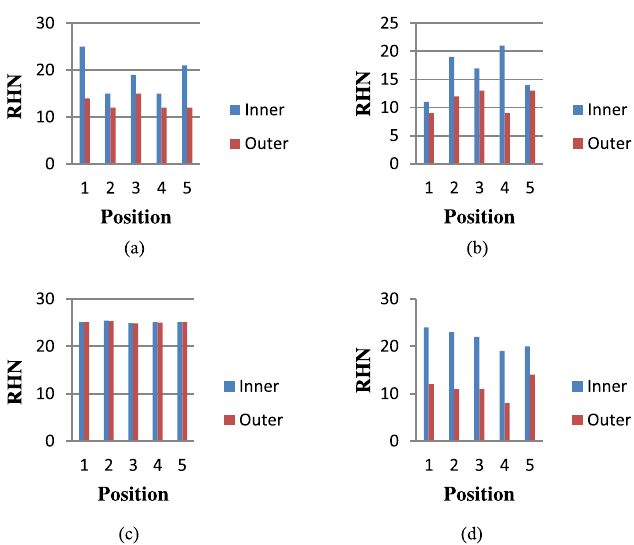
Fig. 8. Rockwell hardness values vs. indentation point for 8 mm Tin cast tubes at speeds of (a) 650rpm (b) 850 rpm (c) 1050 rpm and (d)